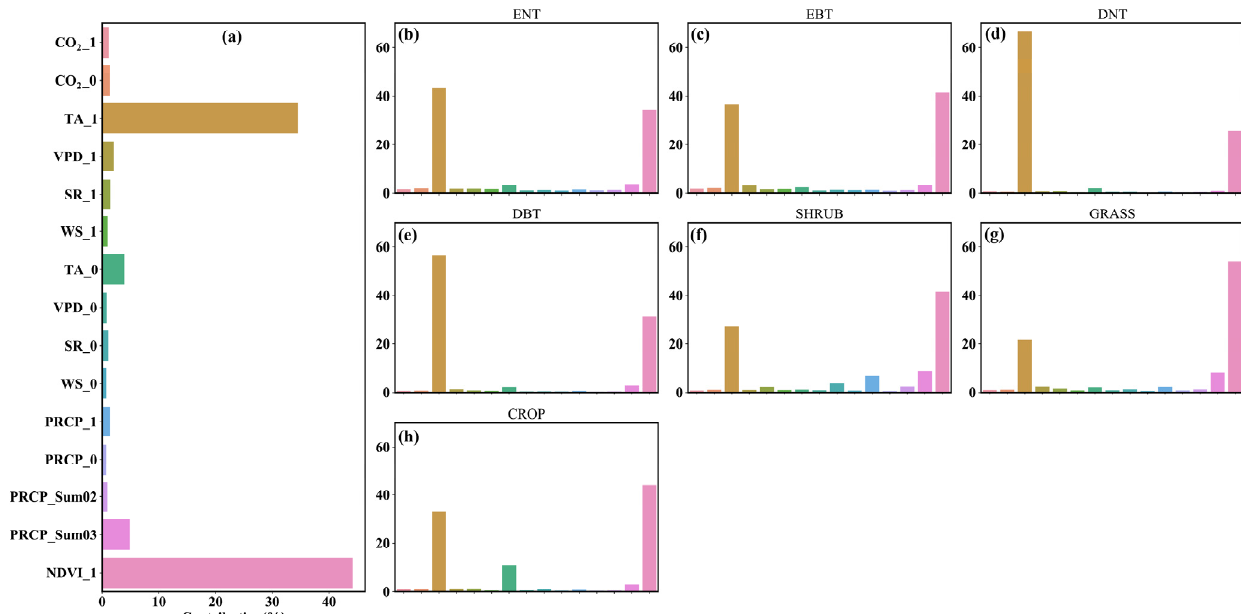
Figure 6. Contributions of the selected explanatory variables for predicting the NDVI for ( a ) the entire study area and ( b – h ) the individual vegetation zones.